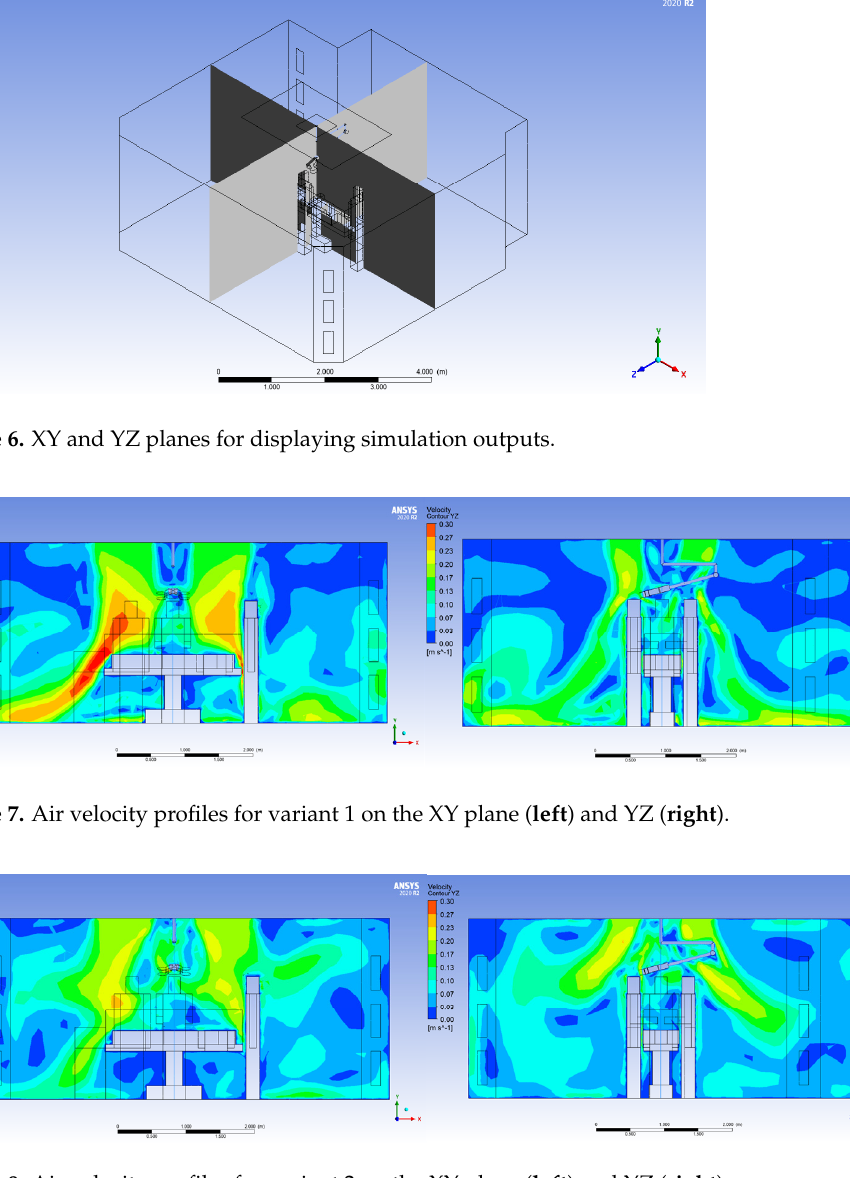
Figure 9. Air velocity profiles for variant 3 on the XY plane ( left ) and YZ ( right ).